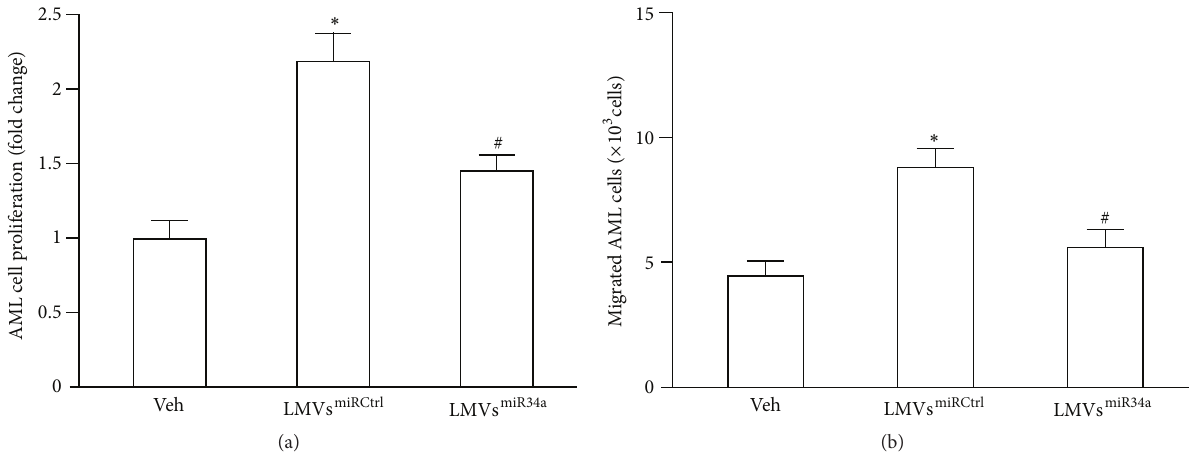
Figure 4: Effects of LMVs miRCtrl and LMVs miR 34 a on AML cell proliferation and migration. (a) Summarized data of AML cell proliferation which was determined by MTT assay. (b) Summarized data of AML cell migration which was determined by transwell assay. Data represents mean ± SEM. ∗ 𝑃 < 0.05 versus veh; # 𝑃 < 0.05 versus LMVs miRCtrl . Veh: fresh culture medium; LMVs miRCtrl : LMVs generated from miRCtrl transfected LSCs; and LMVs miR 34 a : LMVs generated from miR34a mimic transfected